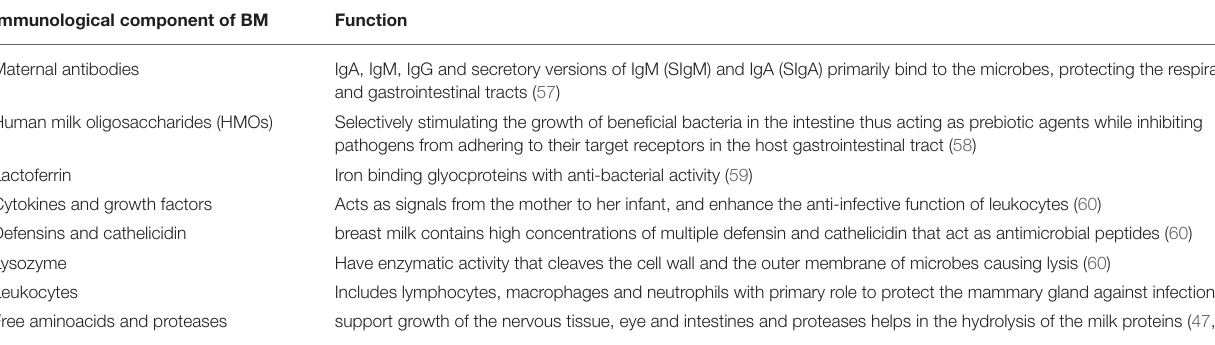
TABLE 1 | Immunological components of BM along with their